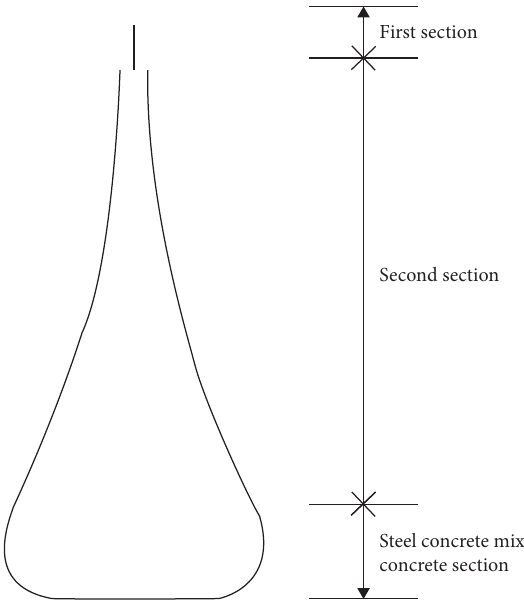
Figure 1: Schematic diagram of the main tower model.